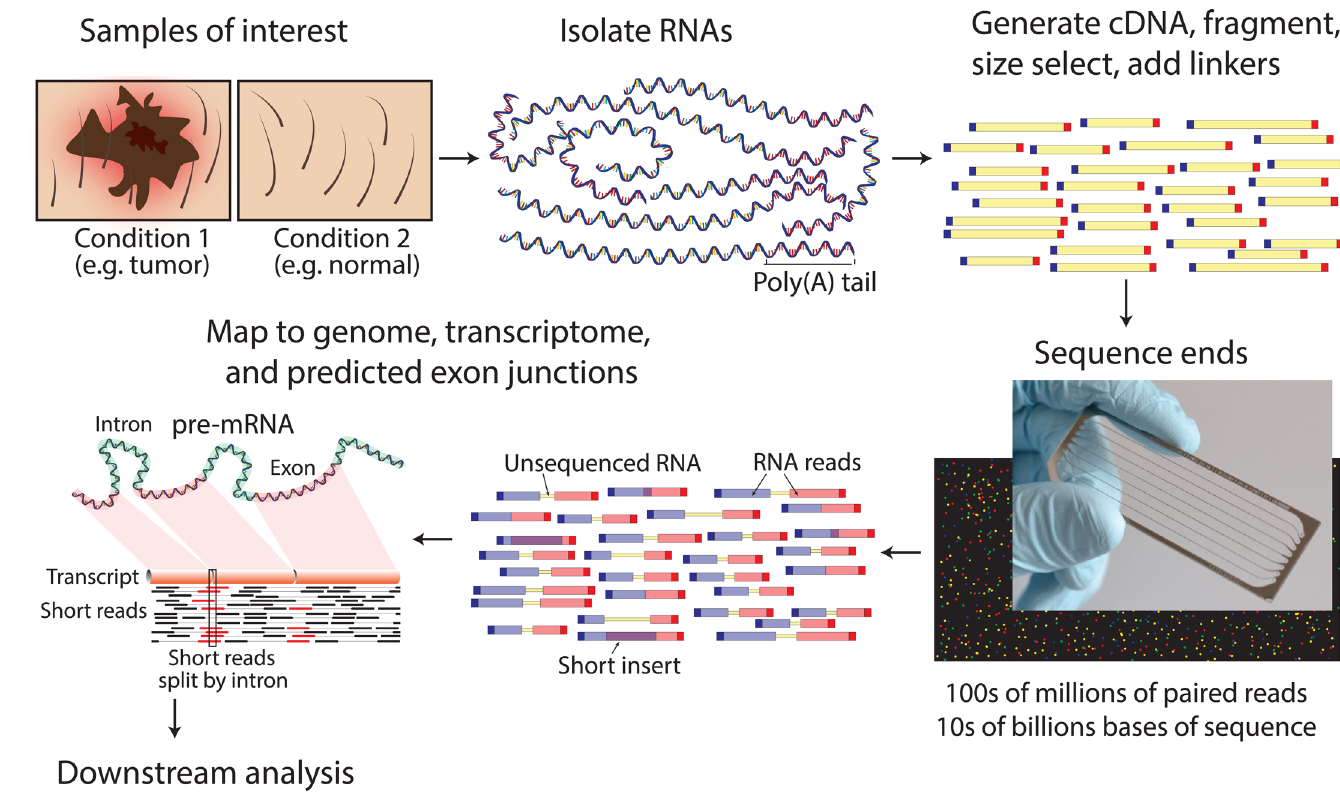
Fig 2. RNA-seq data generation. A typical RNA-seq experimental workflow involves the isolation of RNA from samples of interest, generation of sequencing libraries, use of a high-throughput sequencer to produce hundreds of millions of short paired-end reads, alignment of reads against a reference genome or transcriptome, and downstream analysis for expression estimation, differential expression, transcript isoform discovery, and other applications. Refer to S1 Table, S3 Table, and S7 Table for more details on the concepts depicted in this figure.